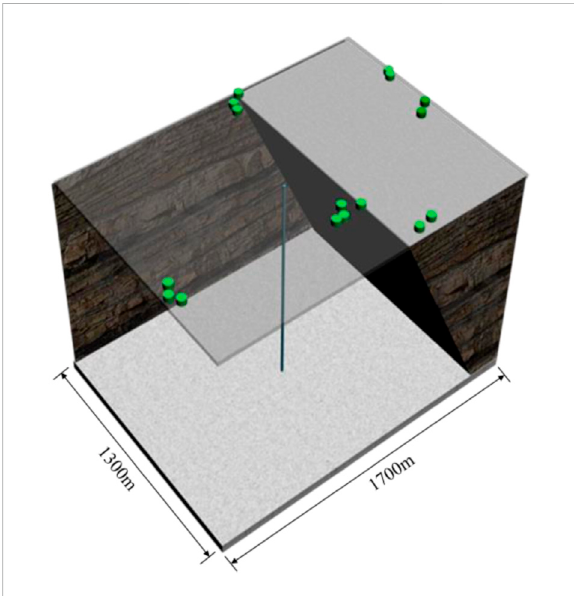
FIGURE 4 Microseismic monitoring stations